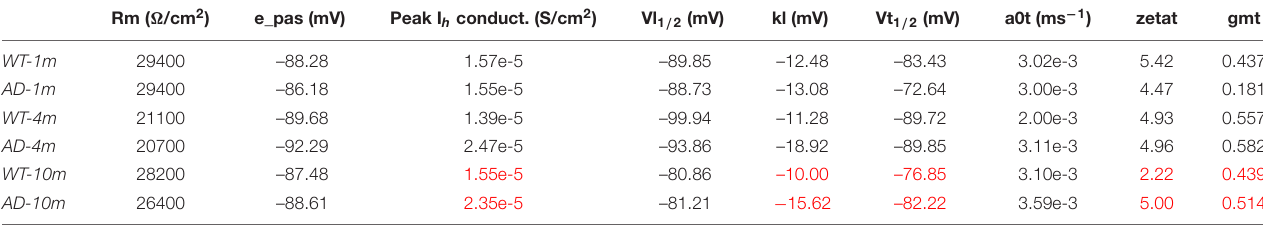
TABLE 2 | Optimized I h model parameters.